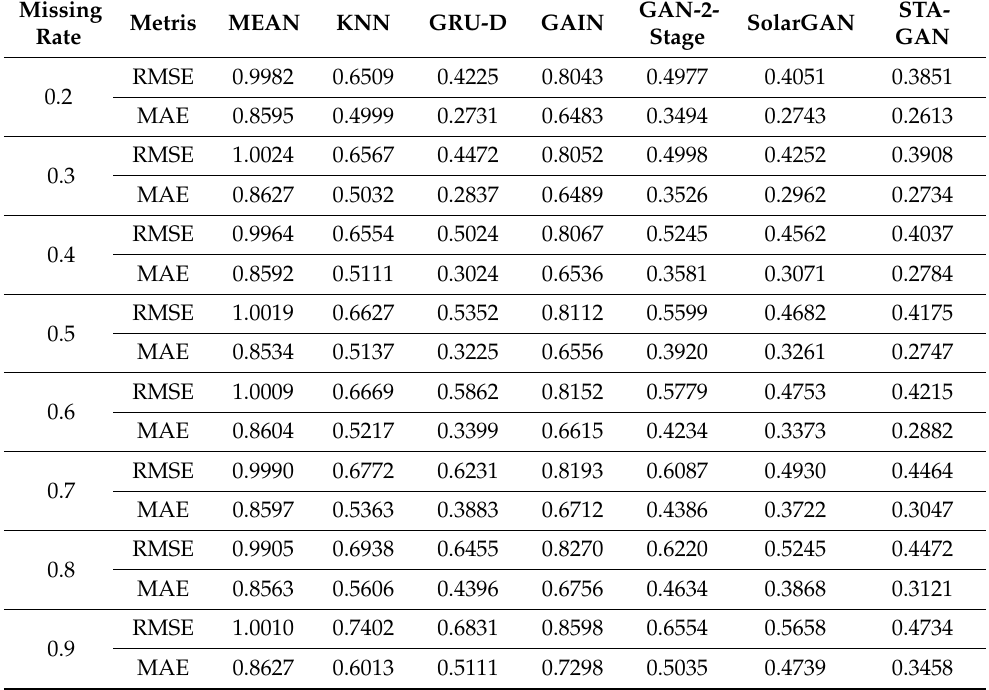
Table 1. The results (RMSE and MAE) of SST-EAST dataset with different missing rates. Missing